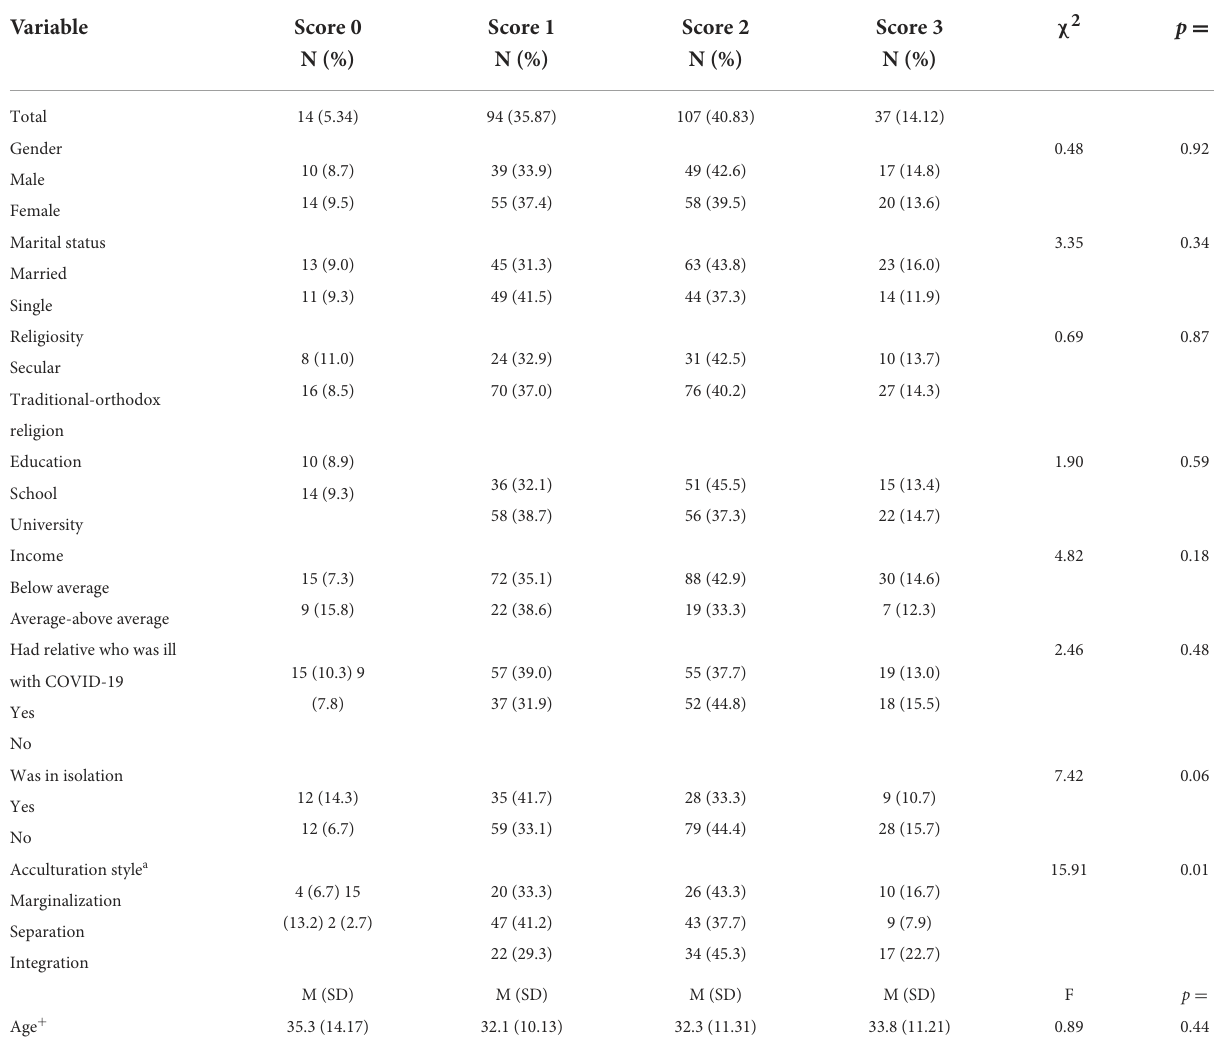
TABLE 2 Sample characteristics by syndemics score ( n =